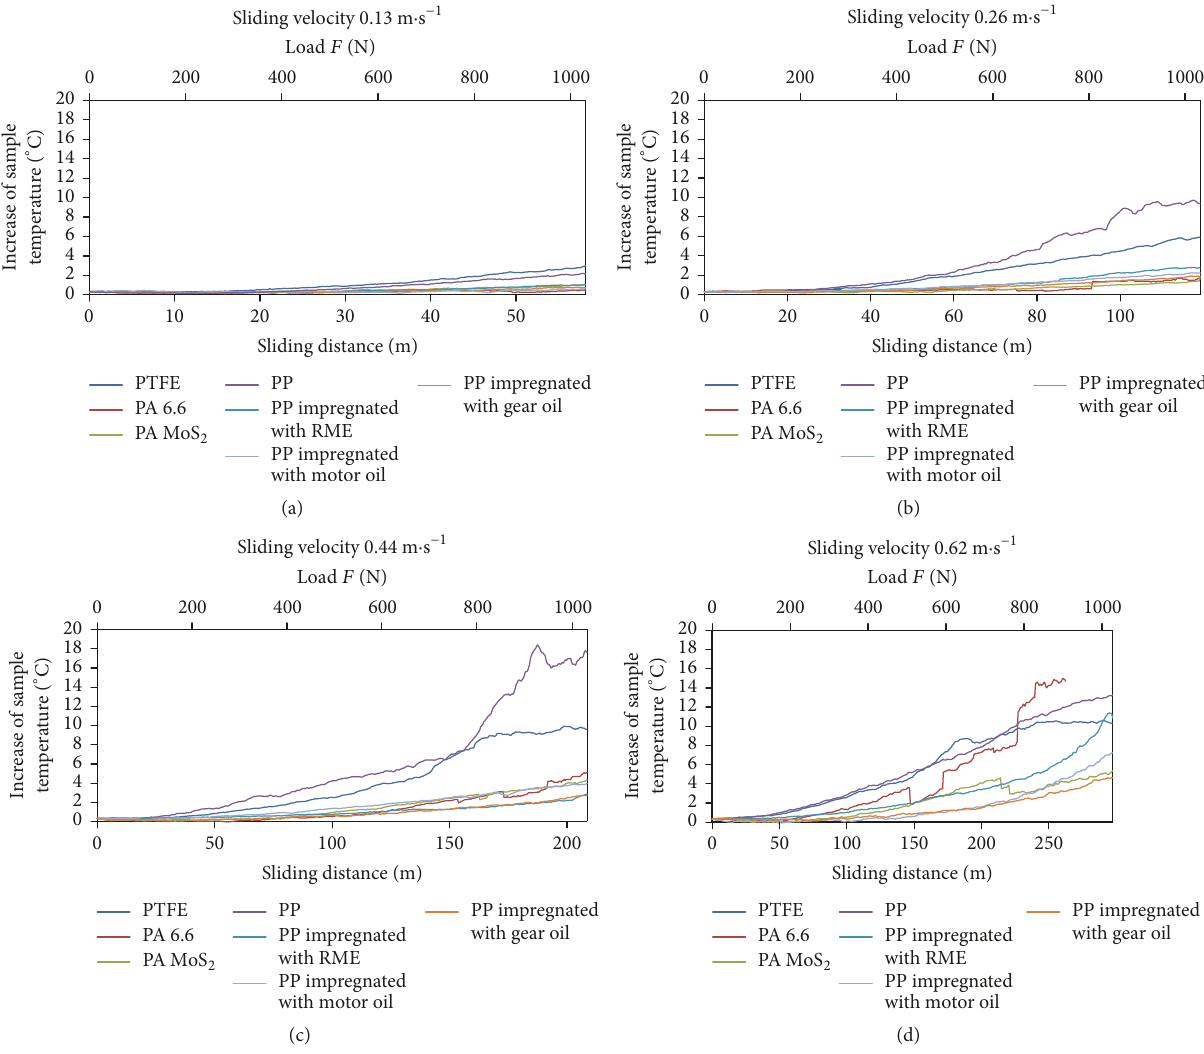
Figure 8: Relationships between sliding distance, load, and temperature of the specimens under various sliding velocities: (a) 0.13, (b) 0.26, (c) 0.44, and (d) 0.62 m ⋅ s −1